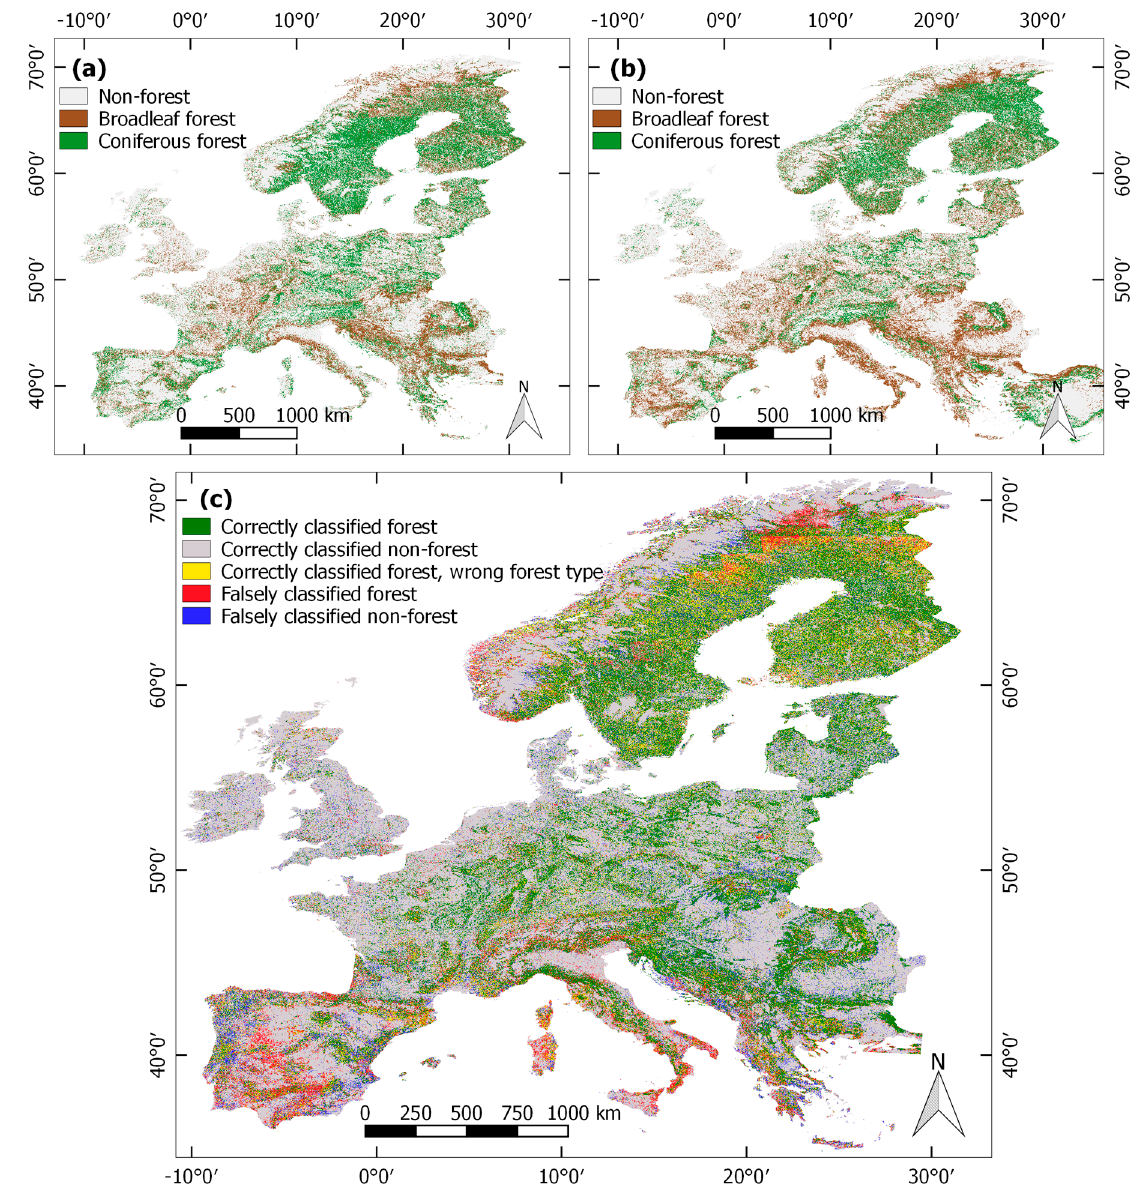
Figure 6. Overview of the forest type maps from ( a ) Sentinel-1, ( b ) Copernicus High Resolution Layers and ( c ) the difference map between the two datasets.